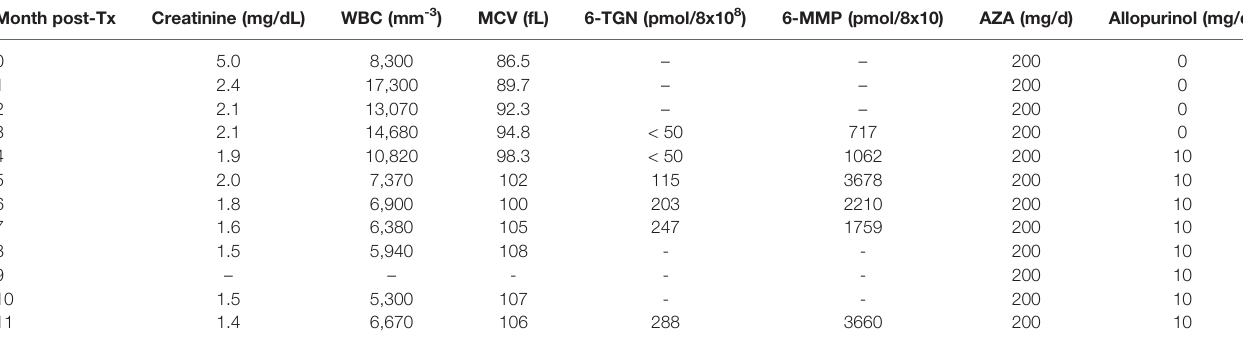
TABLE 1 | Patient with undetectable 6-TGN despite apparently adequate dose of AZA.